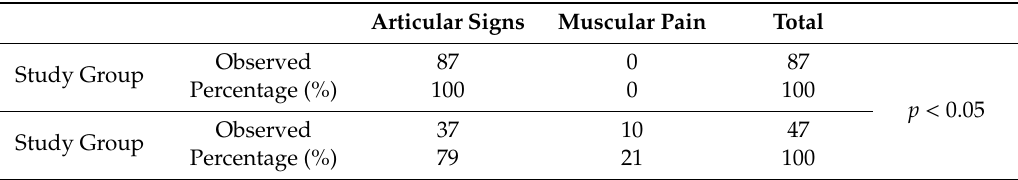
Table 2. Data distribution from the anamnestic form (Helkimo’s index). Significance set at p < 0.05 according to the Chi-Square